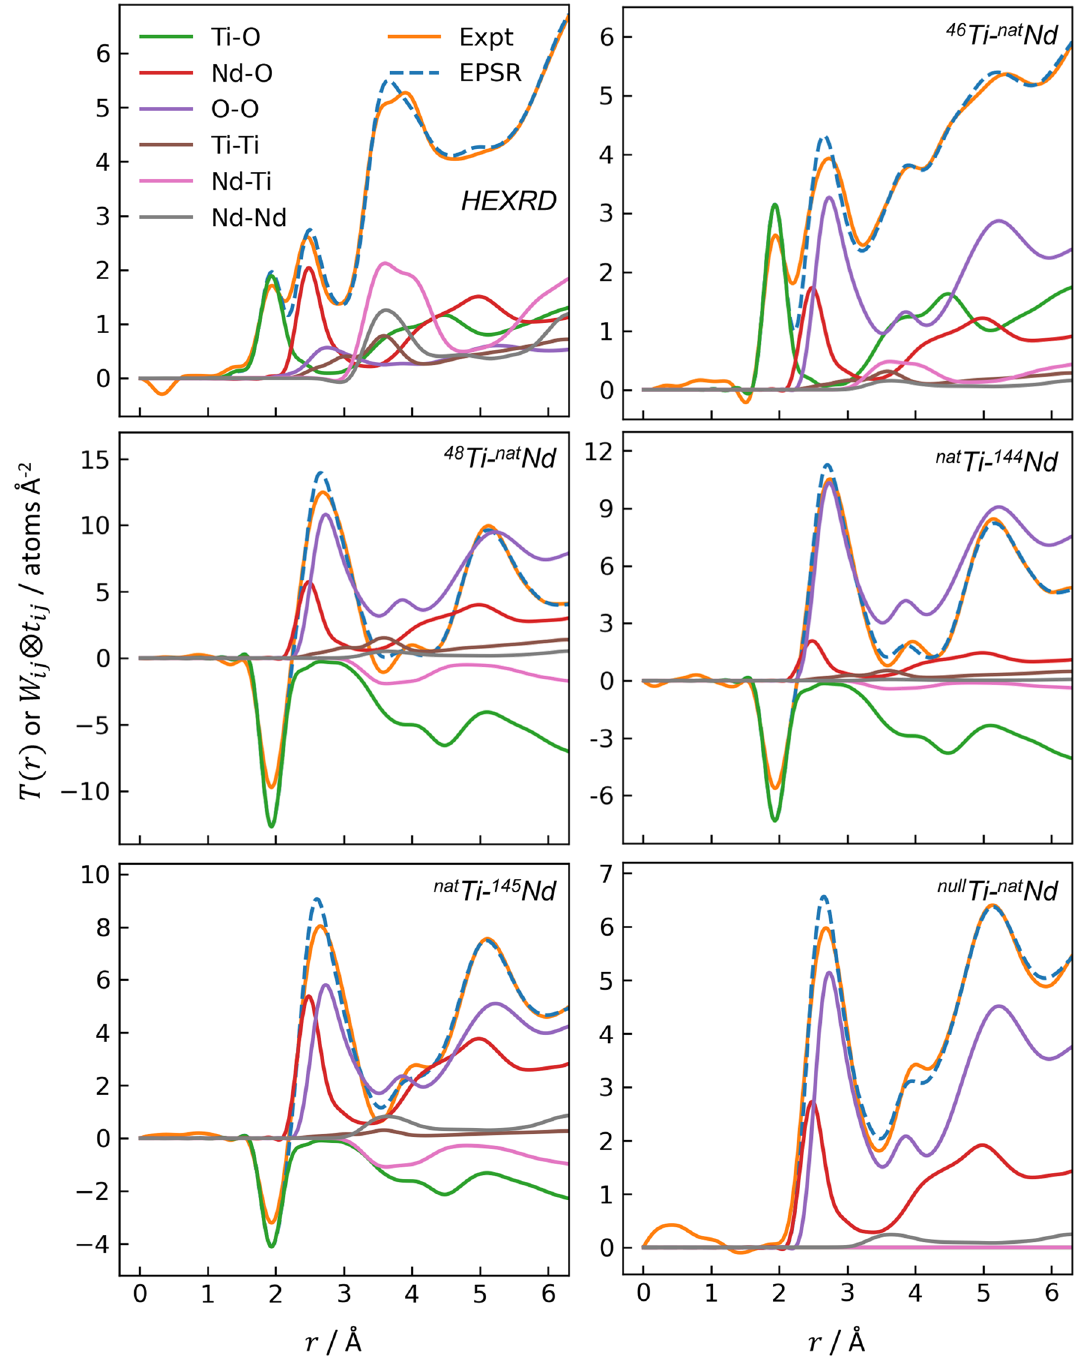
Figure 5. Comparison of the total PDFs (experimental in orange; EPSR in dashed blue) and their comprising weighted partial pair correlations for all measurements. All partials are from